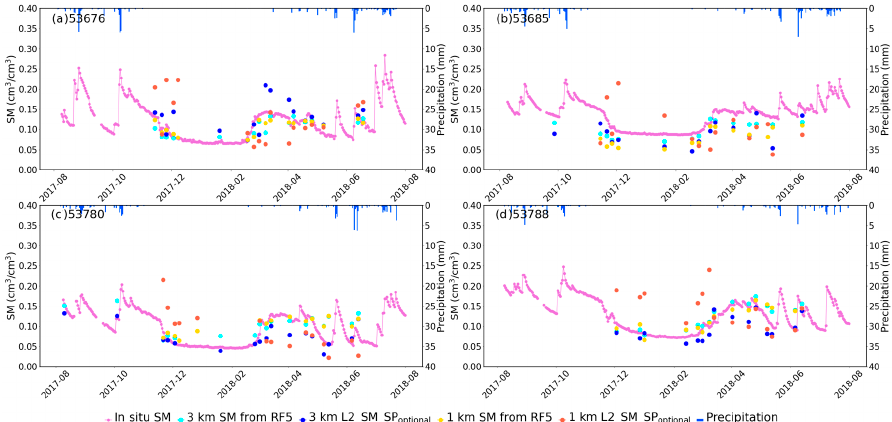
Figure 7. Time series of in situ SM, 3 km, and 1 km SM estimates calculated by RF5, 3 km, and 1 km L2_SM_SP optional data and daily precipitation at four stations.